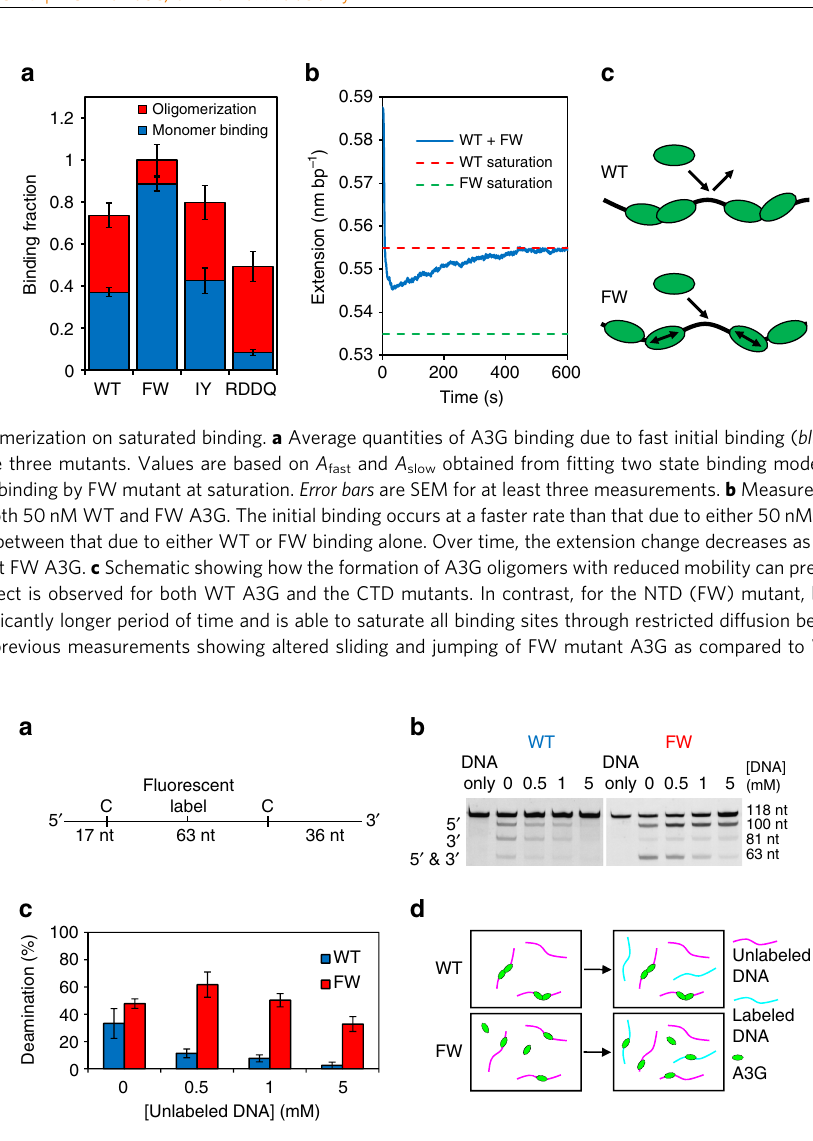
Fig. 7 Comparison of deaminase activity of WT and FW mutant A3G. a Labeled ssDNA construct 118 nts in length with potential deamination sites 17 nts from the 5 ′ -end and 36 nts from the 3 ′ -end. The 63-nt segment between the deamination sites contains a fl uorescently labeled thymine. After deamination, the label will be on a 100-, 81- or 63-nt-long strand if the 5 ′ -site, 3 ′ -site or both sites are cleaved, respectively. b Gel electrophoresis used to determine deaminase activity of WT ( left ) and FW mutant ( right ) A3G. A3G (25 nM) is preincubated with a 69-nt unlabeled ssDNA construct without deamination sites for 3 min before the labeled ssDNA is added at 100 nM and allowed to deaminate for 10 min. In lanes 2 through 5, a concentration of 0, 0.5, 1 and 5 mM unlabeled DNA is used. Lane 1 is a control with the labeled ssDNA construct only. Labeled ssDNA with the 5 ′ -site, 3 ′ -site or both sites deaminated appear in distinct bands. c Percentage of potential sites deaminated as a function of unlabeled DNA concentration for both WT and FW mutant A3G. Error bars show SD of at least three independent experiments. Preincubating WT A3G with unlabeled DNA before the introduction of the labeled DNA signi fi cantly reduces deaminase activity. In contrast, FW mutant A3G continues to deaminate the labeled DNA even when preincubated with large amounts of unlabeled DNA. Results indicate that the deaminase activity of A3G is strongly repressed by A3G oligomerization. d Representation of effect of A3G oligomerization on catalytic activity. During pre-incubation, WT A3G forms dimers, which inhibits the deamination of the subsequently added labeled DNA. In contrast, the FW mutant A3G remains in the monomeric state during pre-incubation and retains its deaminase for the three-fold higher fast on rate k 1 for A3G FW, compared with the WT and CTD mutant A3G proteins. The appearance of immobile A3G dimers on ssDNA effectively slows down the association of incoming monomers, which would have to perform several binding attempts before a successful association event.